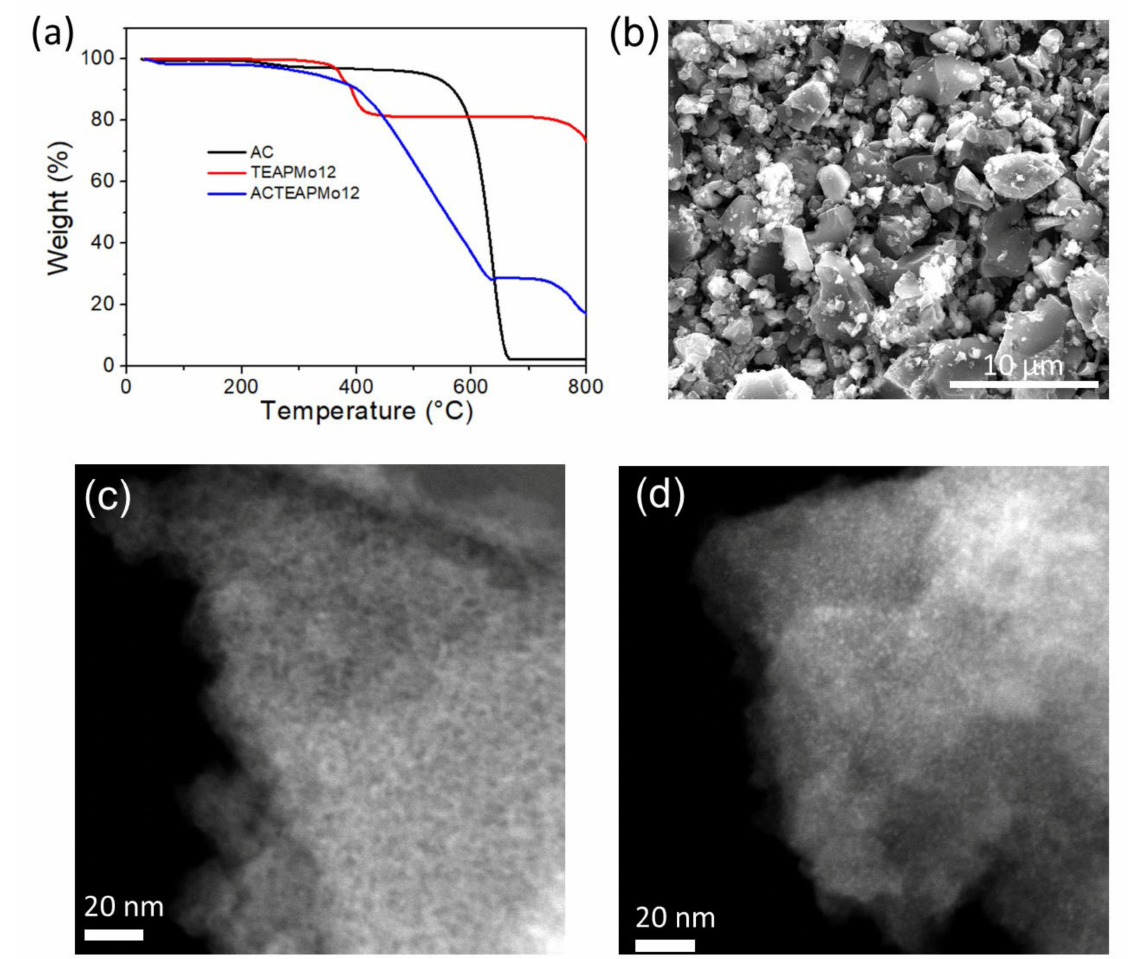
Figure 3. ( a ) The thermogravimetric curves of AC, TEAPMo12 and AC/TEAPMo12. ( b ) SEM image of AC/TEAPMo12. HAADF-STEM images of ( c ) AC and ( d )